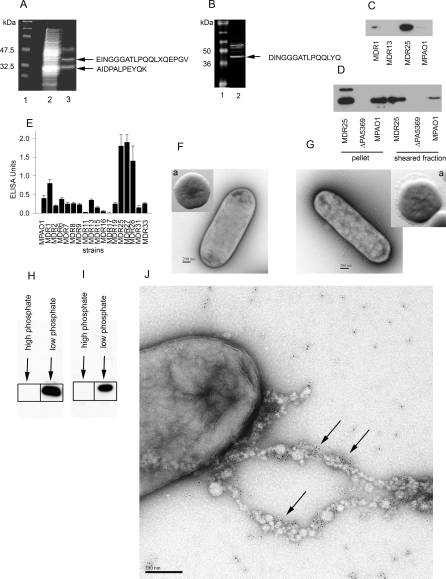
Identification of Appendage-Like Structures(A, B) Fractionation of sheared cell surface proteins by 10% Tris-Glycine SDS-PAGE and identification of abundant proteins by N-terminal sequencing.(A), Lane 1, molecular weight standards (Bio-Rad, broad range, pre-stained); lane 2, strain MDR25; lane 3, strain MDR1. Black arrows show proteins of strain MDR1 subjected to N-terminal sequencing.(B) Lane 1, molecular weight standards (Invitrogen, SeeBlue Plus 2 pre-stained); lane 2, strain 13. Black arrow shows protein subjected to N-terminal sequencing.(C) Immunoblot analysis of cell surface sheared proteins isolated from strains MDR1, MDR13, MDR25, and MPAO1 by using affinity purified polyclonal anti-PA5369 antibody.(D) Immunoblot analysis of pellet and sheared surface proteins from strains MPAO1, MPAO1 derivative PA5369 mutant, and clinical strain MDR25. Colonies were collected and suspended in 200 μl PBS up to final density of 5.0 (600 nm) followed by vortexing for 2 min and centrifuging at 5,000g, 5 min. Sheared material in 10 μl of supernatant was denatured by boiling with 10 μl sample buffer and 10 μl was loaded on gel wells to be separated by 10% glycine SDS-PAGE. The remaining pellet was resuspended in 50 μl of sample buffer, boiled, and 2 μl were loaded on gel wells. PstS protein was identified by immunoblot using anti-PA5369 antibody.(E) Enzyme-linked immunosorbent assay (ELISA) to detect PA5369-like protein on cell surfaces of MPAO1 and MDR clinical P. aeruginosa strains. Data are mean ± SD (n = 3).(F, G) TEM images of strain MDR25 grown on (F) PIA supplemented with 1 mM K-phosphate buffer and (G) on PIA.(H, I) Immunoblot of (H) sheared surface proteins and (I) cell pellet proteins in strain MDR25 grown on PIA (low phosphate) versus PIA supplemented with 1 mM K-phosphate buffer (high phosphate).(J) Immuno-electron microscopy of strain MDR25. Gold spots identified with arrows indicate the protein recognized by anti-PA5369 antibody on cell surface structures.